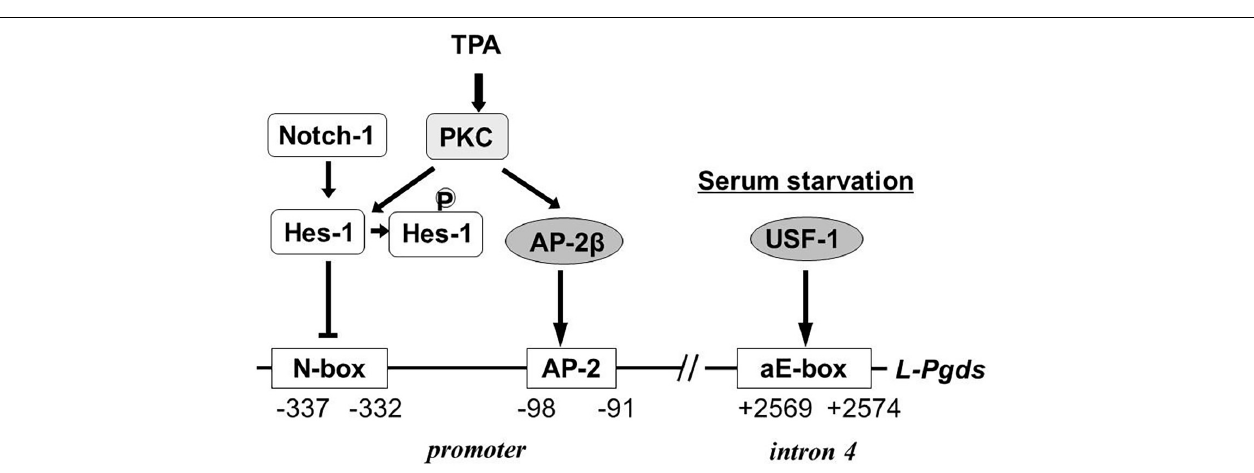
FIGURE 6 | Regulatory mechanism of human L-Pgds gene expression in brain-derived TE671 cells (Fujimori et al., 2005, 2008; Fujimori and Urade, 2007). L-Pgds gene expression is lowered by the Notch-Hes signal via an N-box, but enhanced by AP-2 β through the AP-2 element. TPA activates PKC, followed by phosphorylation of Hes-1 to cancel the binding of Hes-1 to the N-box. Upstream stimulatory factor-1 (USF-1) activates L-Pgds gene expression through the atypical E-box (aE-box) in the intron 4. Serum starvation induces further L-Pgds gene